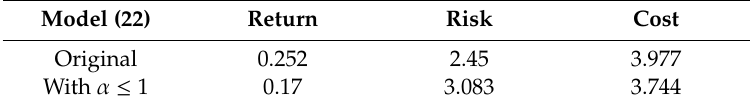
Table 3. Characteristics of the portfolio selected via Model (22) and its revised